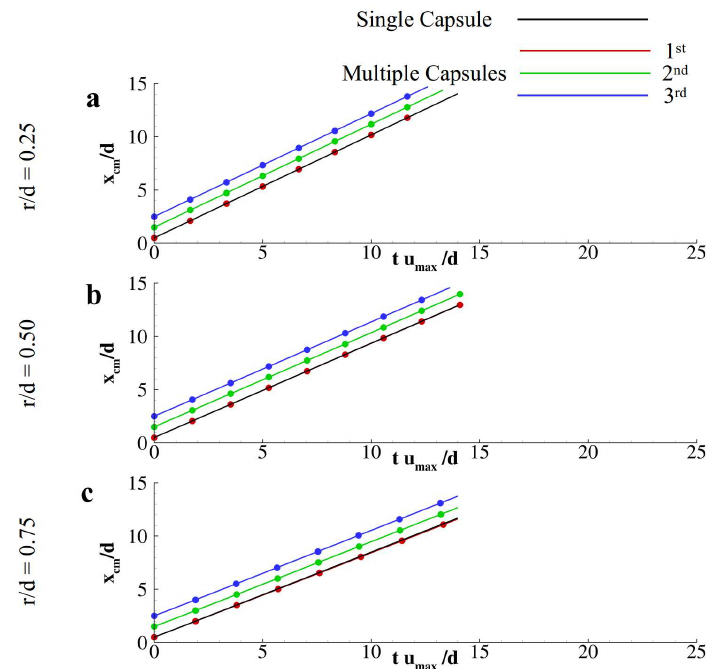
Figure A2. Transport of three aligned capsules ( l / d = 1.0) in the micro-channel. Distribution of the x -coordinate of the capsule centre of mass over time for r / d = 0.25 ( a ); r / d = 0.25 ( b ); and r / d = 0.25 ( c